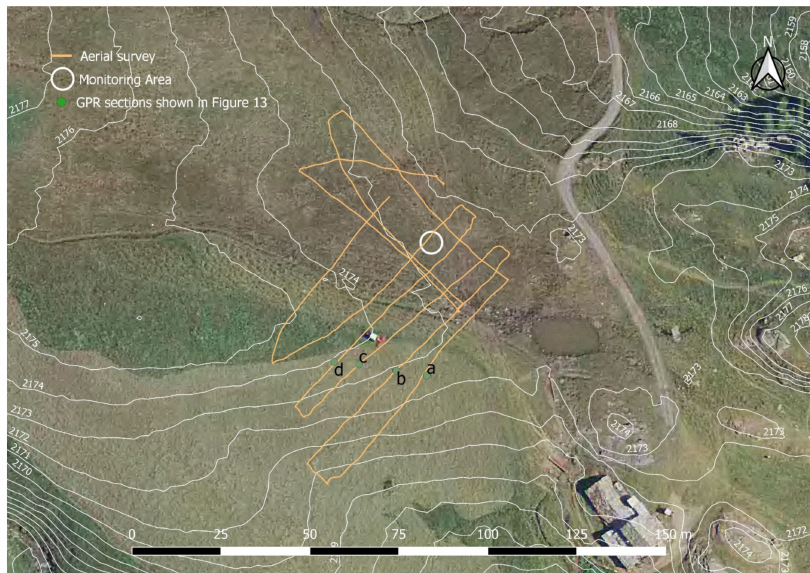
Figure 5. Gressoney survey map: the path of the aerial survey is painted in white. The white circle represents the small monitoring area where density and snow depth measurements are available. Contour lines every 1 m. Letters from a to d indicate GPR sections shown in the results section. Map rendering with QGIS [32]. Base map: 2012 Ortophoto by Aosta Valley regional service